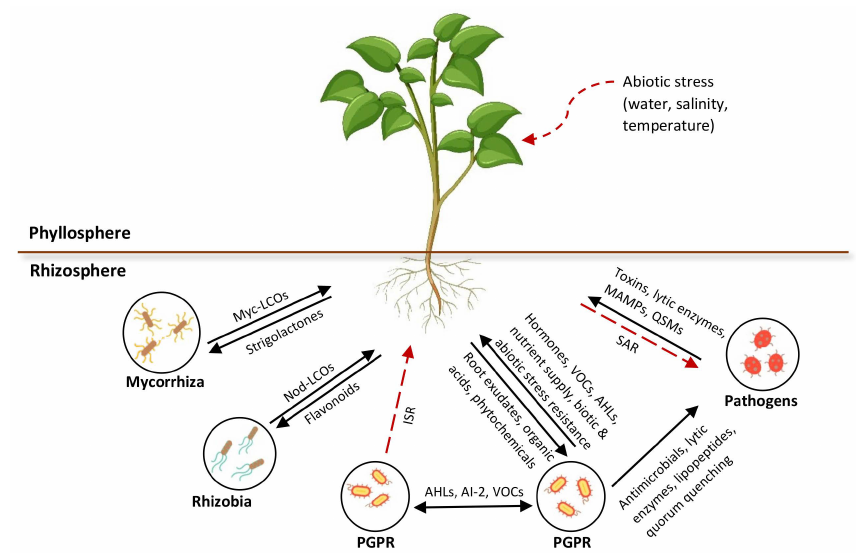
Figure 3. Overview of rhizosphere communication in intra- or interspecies signaling among mi- croorganisms and interkingdom signaling between microbes and plants. Myc, mycorrhizal; LCOs, lipo-chitooligosaccharides; Nod, nodulation; VOCs, volatile organic compounds; Ais, autoinducers; AHLs, N-acyl homoserine lactone; QSMs, quorum sensing molecules.